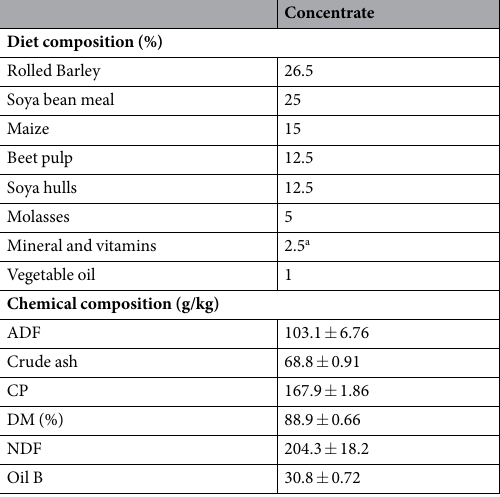
Table 2. Diet and chemical composition of concentrate diet offered. a Mineral and vitamin composition: vitamin A (10 mIU/kg), vitamin D 3 , (2 mIU/kg), vitamin E (40 mg/kg), iodine (8 mg/kg), cobalt (40 mg/kg), copper (88 mg/kg), manganese (81 mg/kg), zinc (139 mg/kg) and selenium (11 mg/kg). b Mineral and vitamin composition for concentrate post puberty is the same as above with the exception of copper (80 mg/kg). c Oil B = Acid